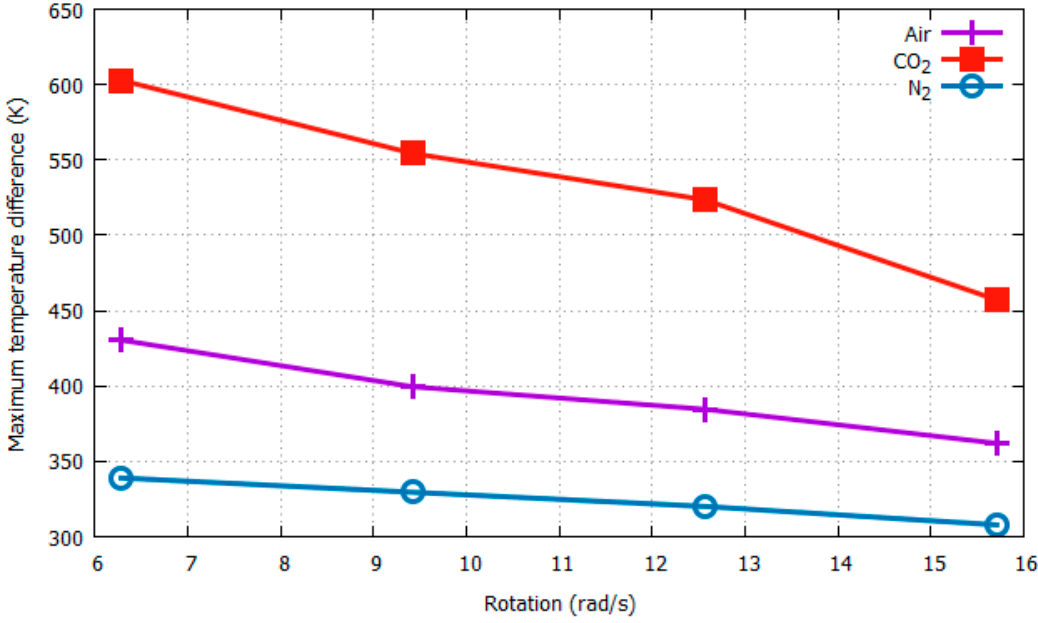
Figure 13. Δ T_Y max w.r.t rotation at 3 g with varying gas media. Figure 13. ∆ T_Y max w.r.t rotation at 3 g with varying gas